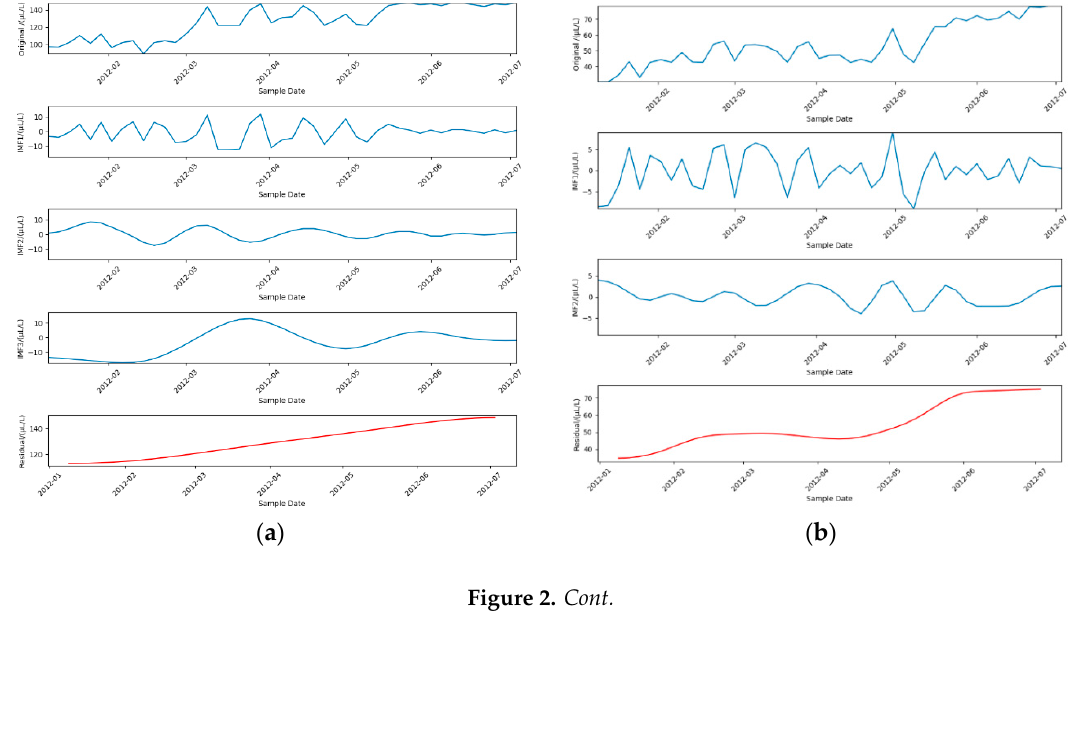
Table 2. Grey relational degree of each factor.